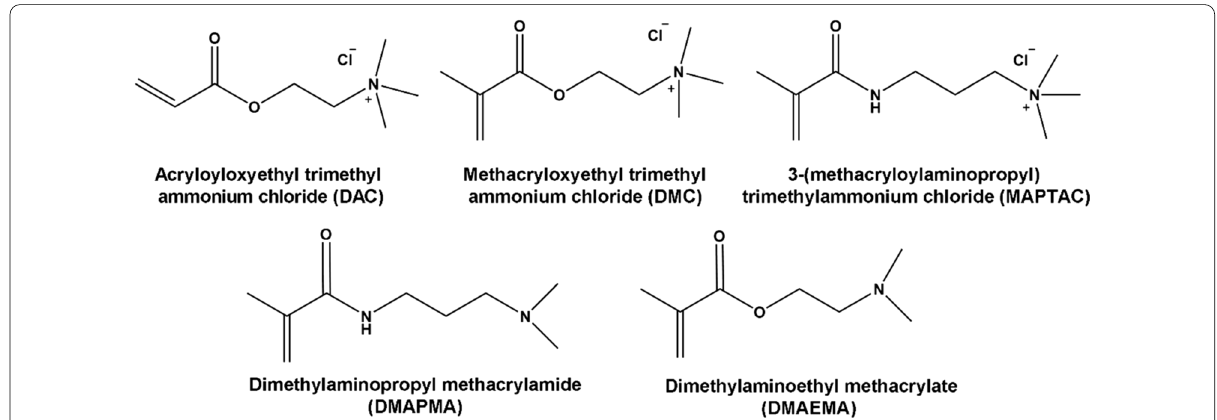
Fig. 1 Chemical structure of the cationic